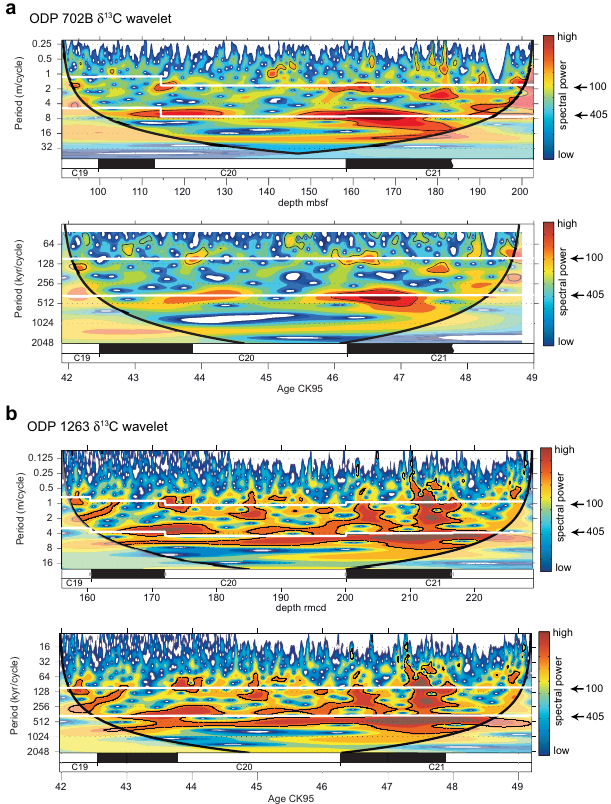
Figure 4. Evolutionary wavelet power spectra of bulk stable car- bon isotope data from ODP Hole 702B (a) and Site 1263 (b) for magnetochrons C19r to C21r in the depth domain and versus age. The age model is based on magnetostratigraphy using the timescale of Cande and Kent (1995). The shaded contours in the evolutionary wavelet power spectra are normalized linear variances, with blue representing low spectral power and red representing high spectral power. The black contour lines enclose regions with more than 95% confidence. Shaded regions on either end indicate the cone of influ- ence where edge effects become important. Distinct bands that run across the spectra indicate the dominance of Milankovitch frequen- cies. The top and bottom thick white lines are the projected 100 and 405kyr cycle path,